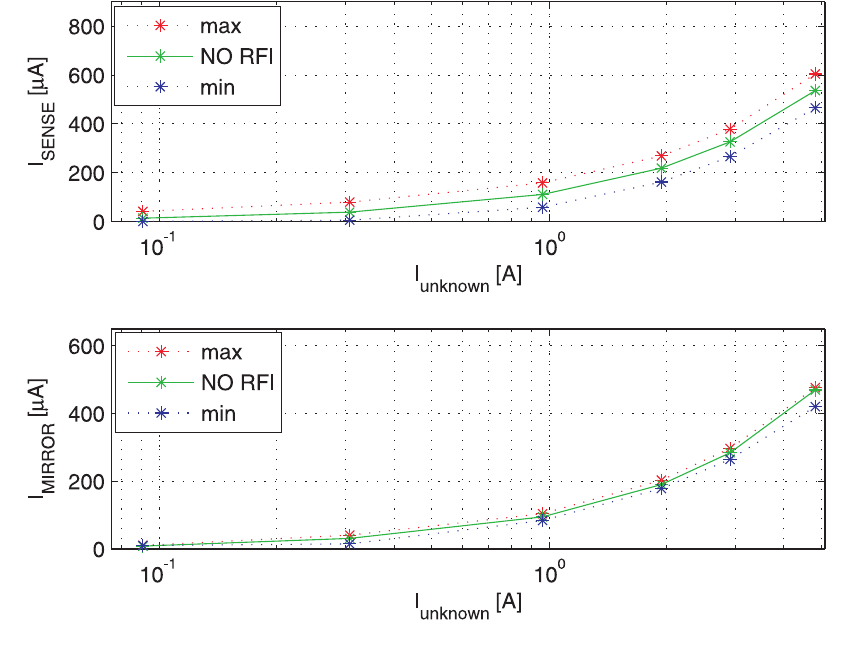
) versus current to MIRROR